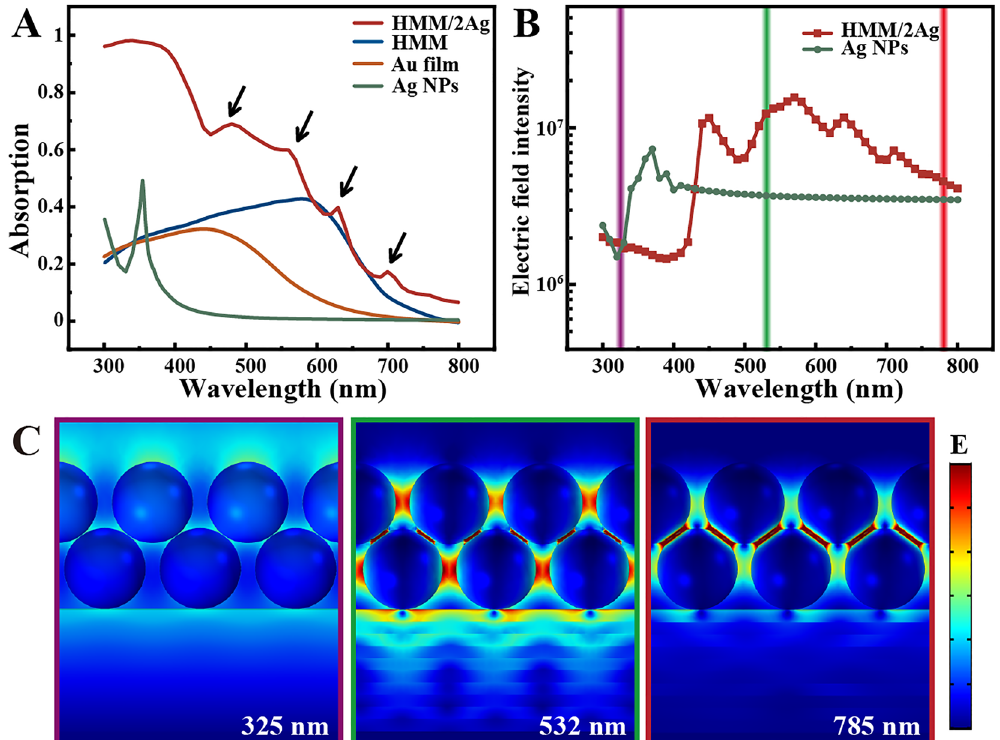
Figure 3: (A) The simulated absorbance spectra of various nanostructures. (B) Simulated electric field intensity of Ag NPs and HMM/2Ag versus the excitation wavelength. (C) Electric field distribution of HMM/Ag nanostructure on the excitation wavelength of 325, 532, and 785 nm,